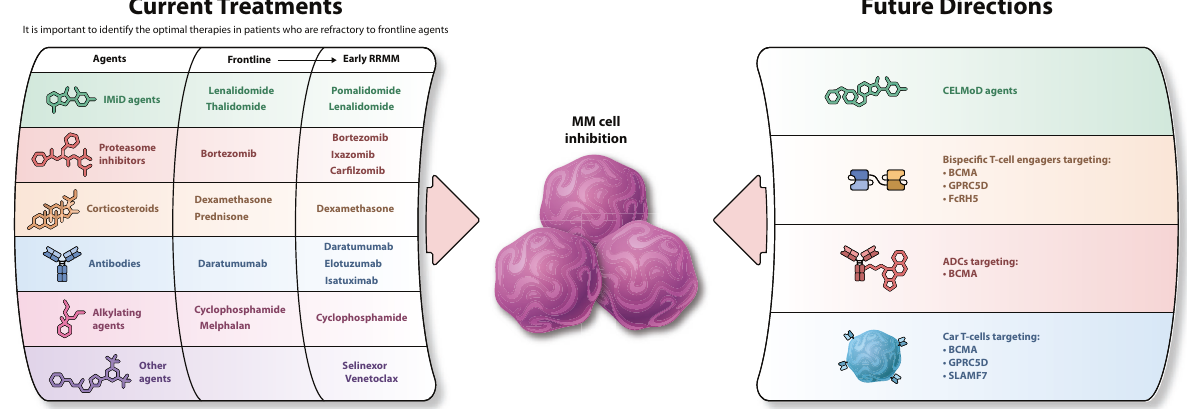
Fig. 1 Overview of current treatment options and future directions in the early RRMM treatment landscape. The agents commonly used for treatment of patients with multiple myeloma in frontline and early relapsed/refractory settings are presented on the left (Current Treatments); agents being evaluated in clinical trials or entering the treatment space are described on the right (Future Directions). ADC antibody-drug conjugate, BCMA B-cell maturation antigen, CAR chimeric antigen receptor, CELMoD cereblon E3 ligase modulating drug, FcRH5 Fc receptor-homolog 5, GPRC5D G-protein coupled receptor family C group 5, mAb monoclonal antibody, MM multiple myeloma, RRMM relapsed/refractory multiple myeloma, SLAMF7 SLAM family member